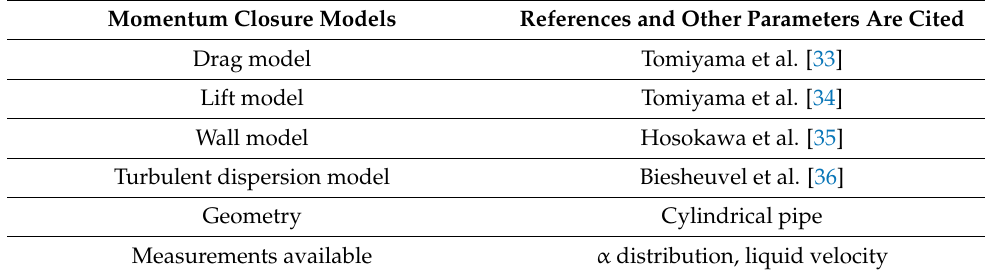
Table 1. Momentum closure models and the test case